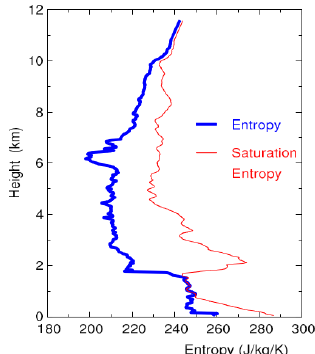
Figure 14. Vertical profiles of the moist entropy (blue line) and the saturation moist entropy (red line) obtained from the dropsonde at ~1551 UTC on 31 July 2007 during the TC4 experiment. The dropsonde was released from the DC-8 aircraft flying at an altitude of 12 km to measure the atmospheric temperature, pressure, wind and relative humidity near the MCS shown in Figure 8.